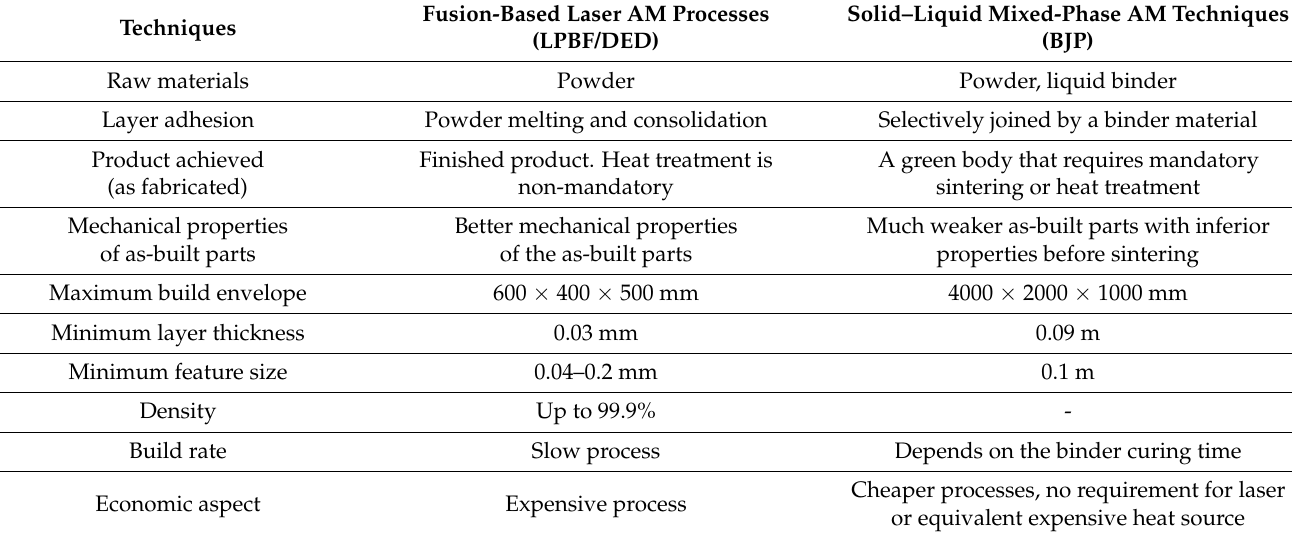
Table 3. Summary of characteristics of fusion-based AM processing and solid–liquid mixed-phase AM processing techniques [30–37].